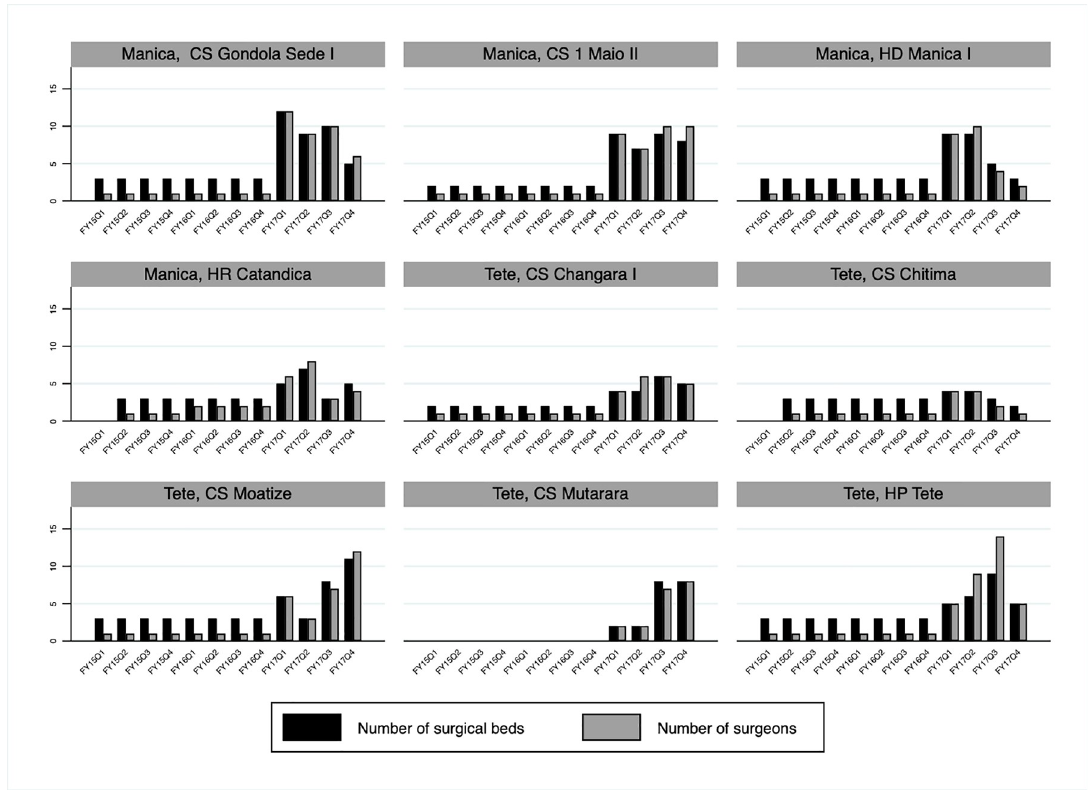
Fig 6. Numbers of surgical beds and surgeons in Manica and Tete, Mozambique FY15 Q1- FY17 Q4 by fixed service delivery site.